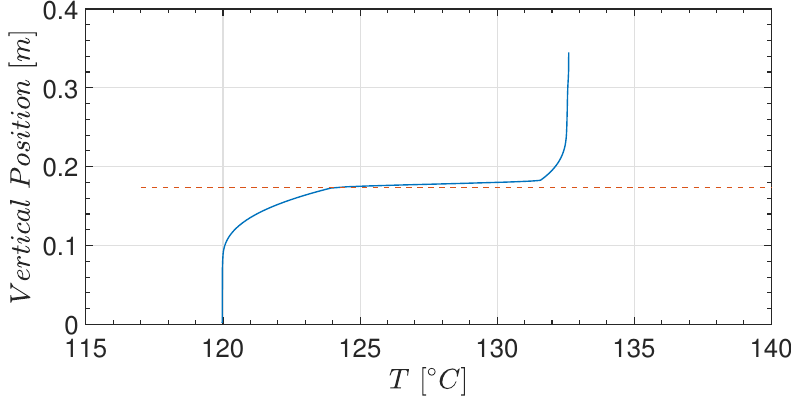
Figure 5. Vertical temperature profile inside the tank at the start of